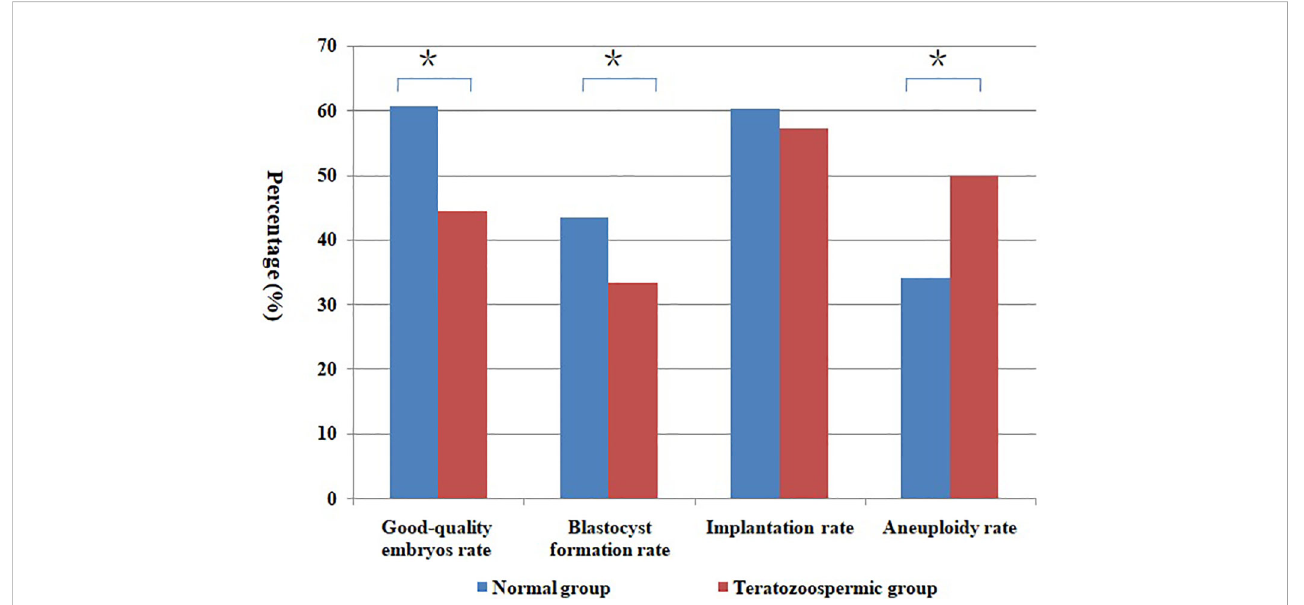
FIGURE 1 Comparison of different rates between normal and teratozoospermic group. *Statistically signi fi cant (P <